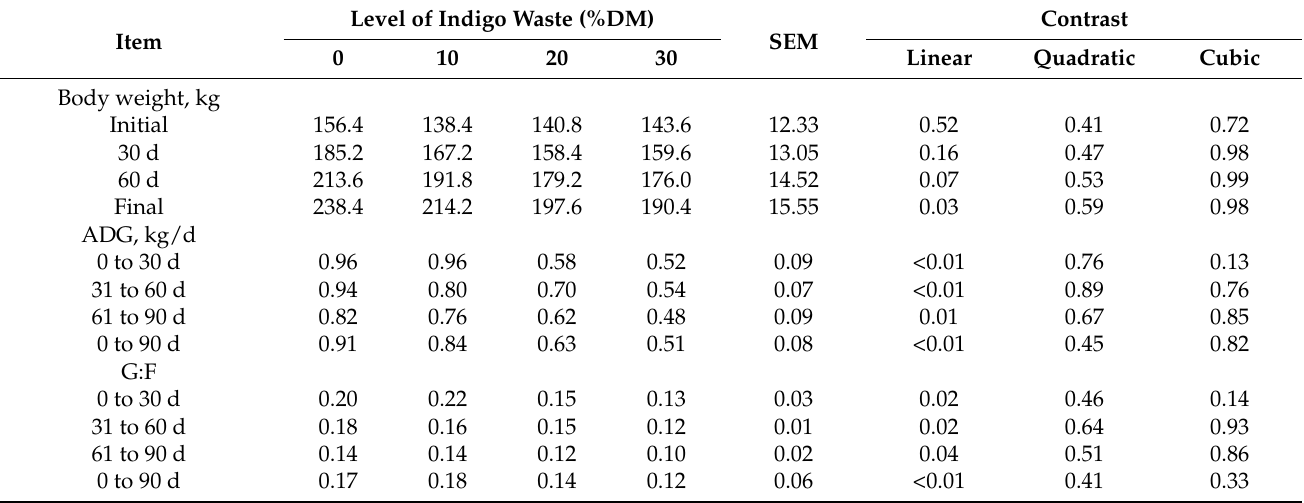
Table 6. Effect of indigo waste on growth performance in growing beef cattle.